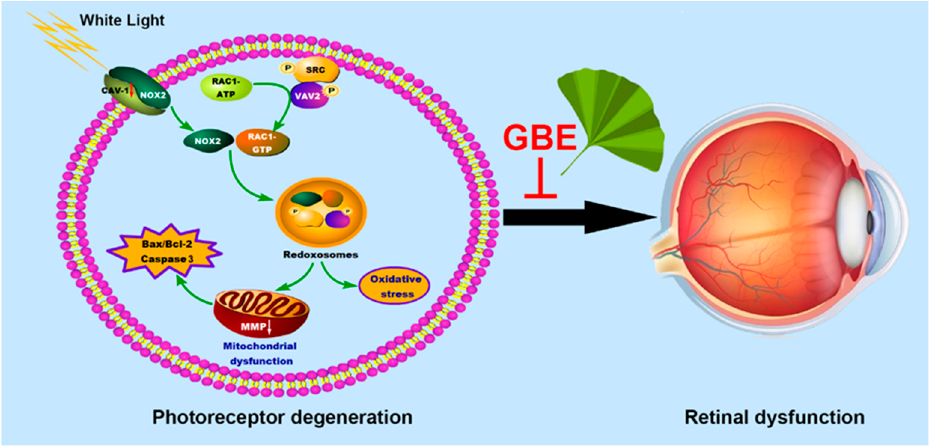
Figure 10. The proposed molecular mechanism of the effect of GBE on WL illumination-induced photoreceptor degeneration.